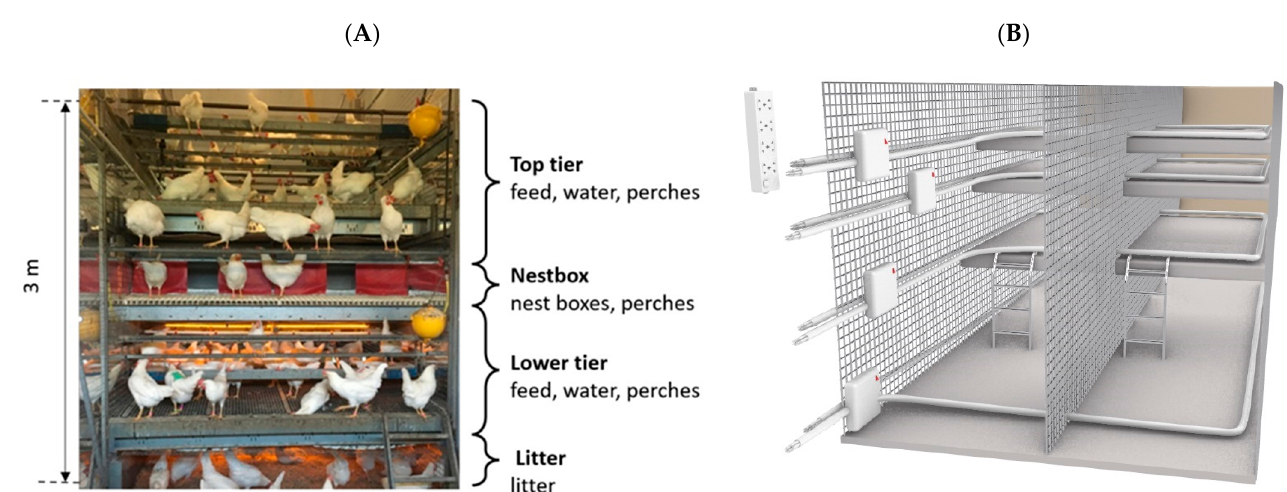
Figure 2. ( A ) Side view of the aviary within one pen with its three aviary zones (top tier, nest box, lower tier) and the littered floor; ( B ) simplified 3D model of the tracking system covering two pens, including the four markers of the four indoor zones and their associated cables.